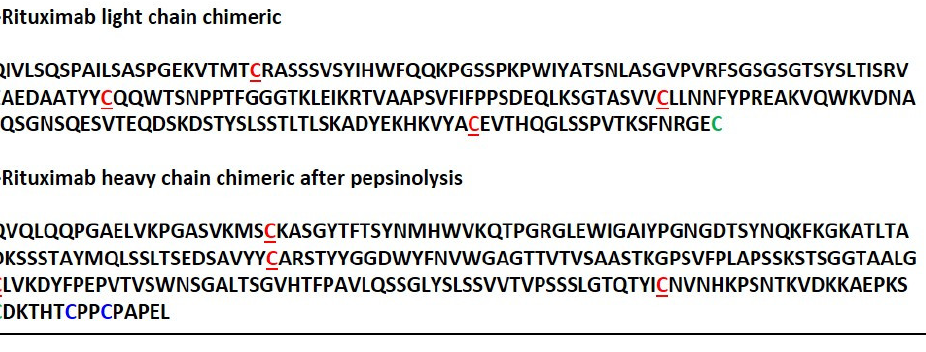
Figure 2. Aminoacidic sequence of intact LC and HC of Rituximab as cut following pepsin hydrolysis. Cysteine involved in intrachain disulfide bridges are underlined and reported in red. C224 of the HC and C213 of the LC that connect the chains are reported in bold green. The free cysteines present in the Fab’ hinge region in the HC are in bold blue.